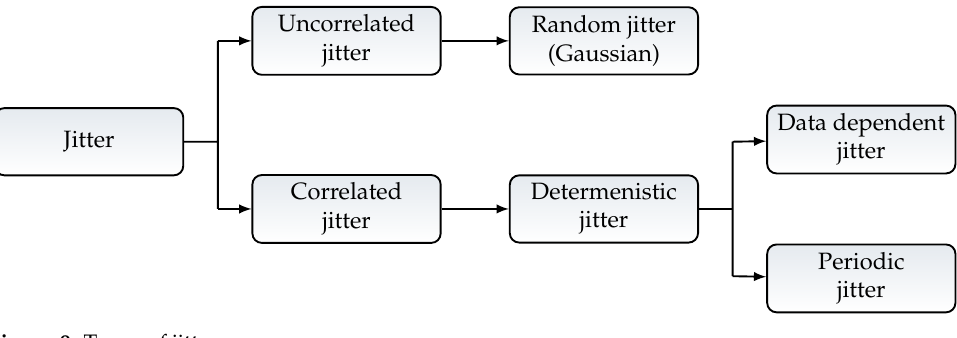
Figure 9. Types of